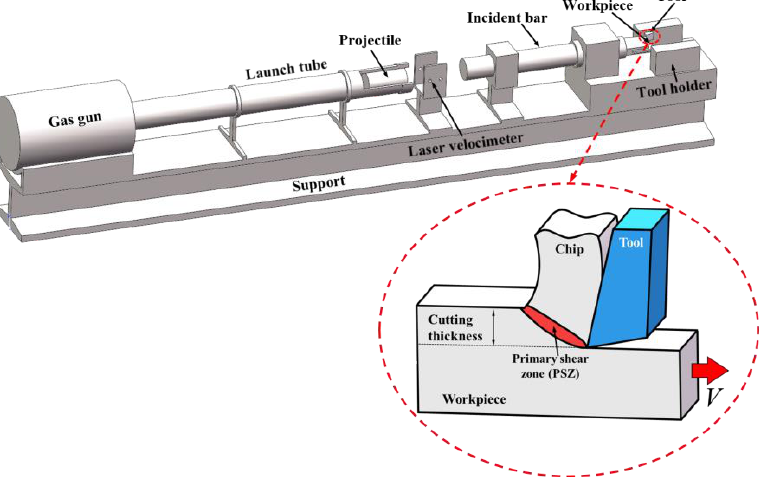
Figure 1. Diagram of high-speed cutting experimental device based on a split Hopkinson pressure bar (SHPB). The insert shows the schematic diagram of the cutting process.